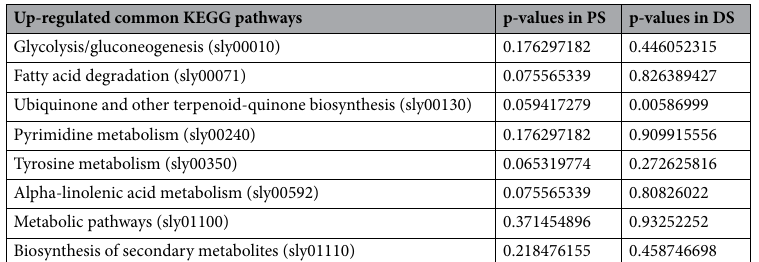
background genes in this pathway. The y-axis represents KEGG pathway.